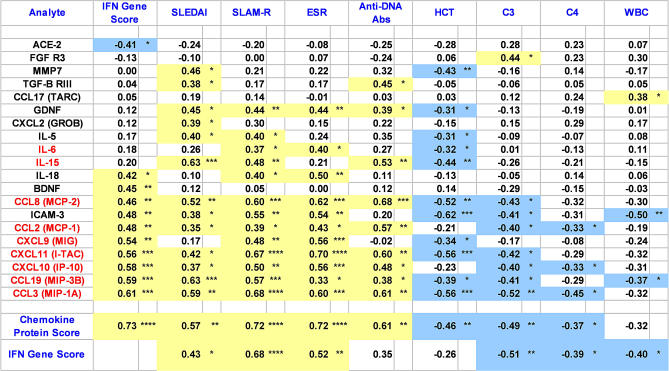
IFN-Regulated Chemokines Are Associated with SLE Disease ActivityShown are 20 serum analytes that exhibited significant positive (highlighted in yellow) or negative (highlighted in blue) correlation coefficients with clinical measures of SLE. The IFN gene score was calculated from 82 IFN-inducible transcripts measured by concurrent whole blood gene expression microarrays. The chemokine protein “score” was calculated using the seven IFN-regulated CC and CXC chemokines highlighted in red. * p < 0.05; ** p < 0.01; *** p < 0.001; **** p < 0.0001. p-Values were obtained by permutation testing.